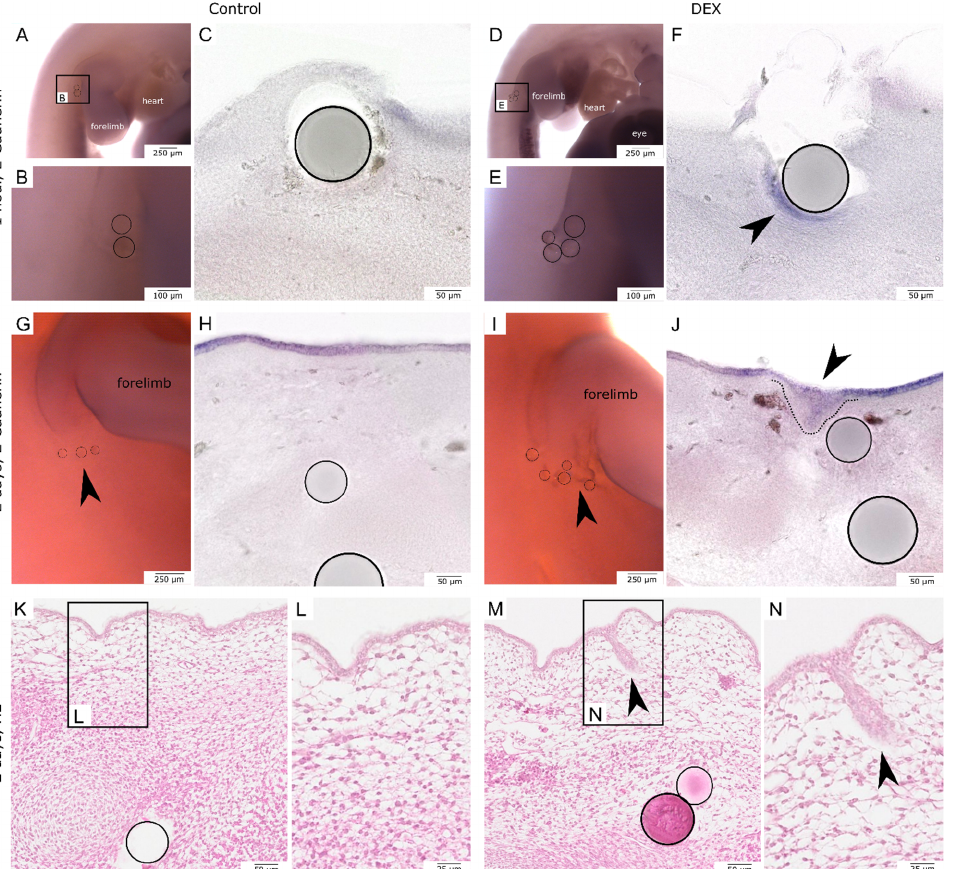
Figure 6. E-Cadherin expression and re-epithelialization of bead-implanted wounds. The images compare the process of re-epithelialization of the wound areas by in-situ hybridization for E-cadherin. ( A , B (higher magnification)) show the whole-mounts of hybridized control wounds after one hour. ( C ) shows a respective vibratome section. ( D , E (higher magnification)) show the whole-mounts of hybridized dex wounds after one hour. ( F ) shows a respective vibratome section. Note the increase in E-cadherin expression in the dex wound (black arrowhead in ( F )) as well as the open incisional wound. ( G ) shows the whole-mount of a hybridized control wound after two days. ( H ) shows the respective vibratome section. ( I ) shows the whole mount of a hybridized dex wound after two days. ( J ) shows the respective vibratome section. Note that after two days, both wounds have re- epithelialized but the dex wound showed a persisting increase in E-cadherin expression. ( K – N ) show the same phenomenon after two days in HE-stained paraffin sections. The epidermal invagination in the HE-stained section of the dex wound is indicated by black arrowheads in ( M , N